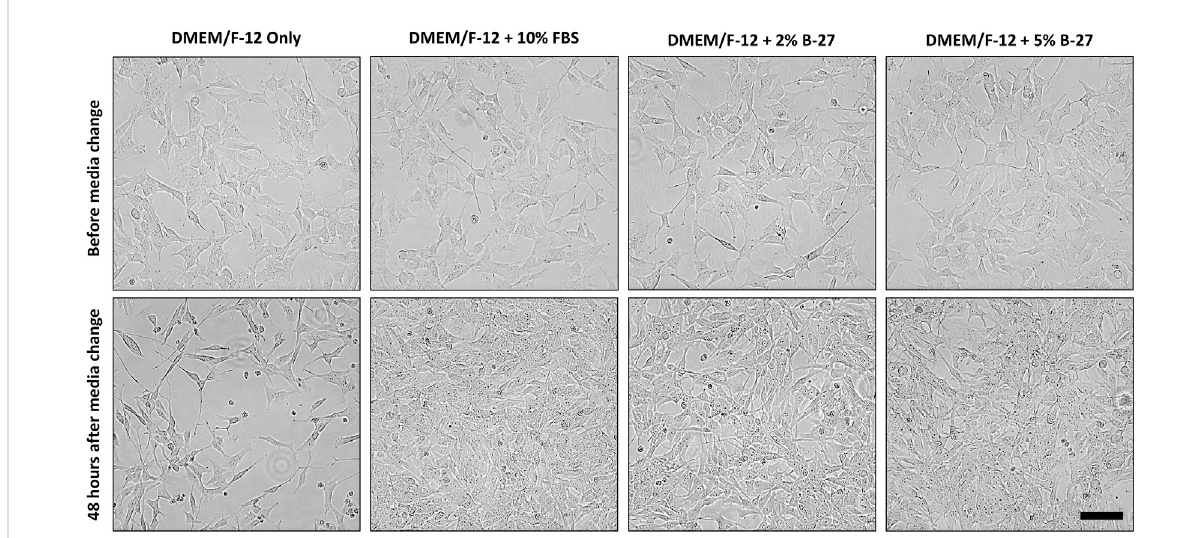
FIGURE 2 B-27 encourages SH-SY5Y cells were seeded into 6-well plates at a density of 300,000 cells per well in DMEM/F-12 + 10% FBS. Once SH-SY5Y cells reached approximately 70% con fl uency, media was replaced with either: DMEM/F-12 only, DMEM/F-12 + 10% FBS, DMEM/F-12 + 2% B-27 supplement or DMEM/F-12 + 5% B-27 supplement. Cells were imaged using the EVOS FLoid microscope ( Thermo Scienti fi c ) before media was replaced and 48 h after media was replaced. Scale bar = 100 μ m. DMEM/F-12, Dulbecco ’ s modi fi ed eagle medium/nutrient mixture F-12 with GlutaMAX supplement; FBS, fetal bovine